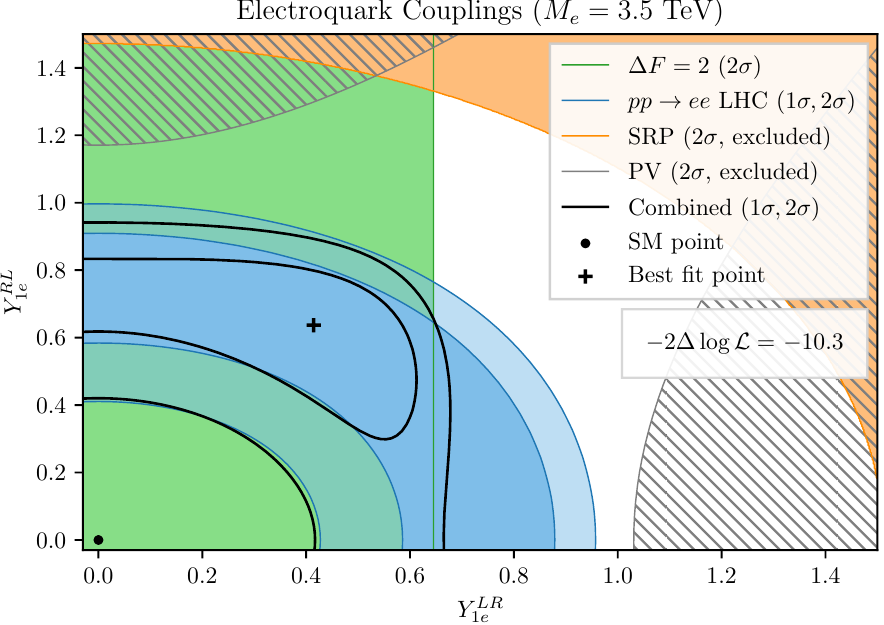
Figure 7. Parameter space region leading to a possible explanation for the excess in di-electrons found by the CMS collaboration (light blue). The solution via real couplings Y LR values of O (0 . 6) , which also yields an improved fit to PV observables [159]. The limit from the electron EDM measurement additionally places a strong constraint on the complex phases of the